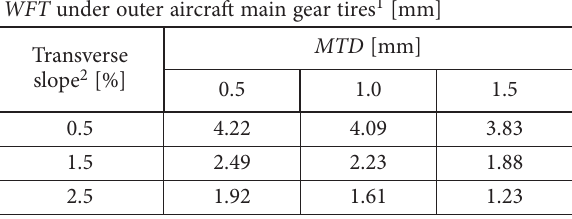
transverse/longitudinal slopes and MTDs